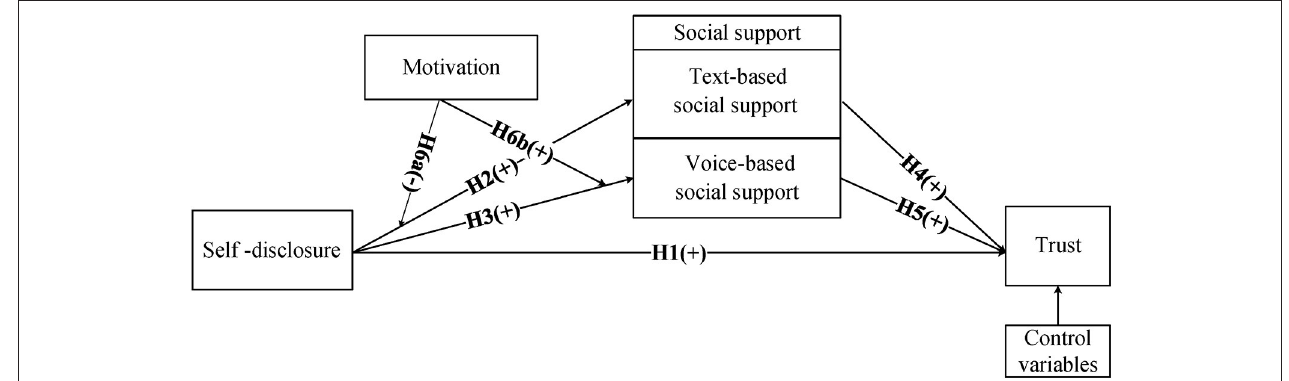
FIGURE 1 | Research model.